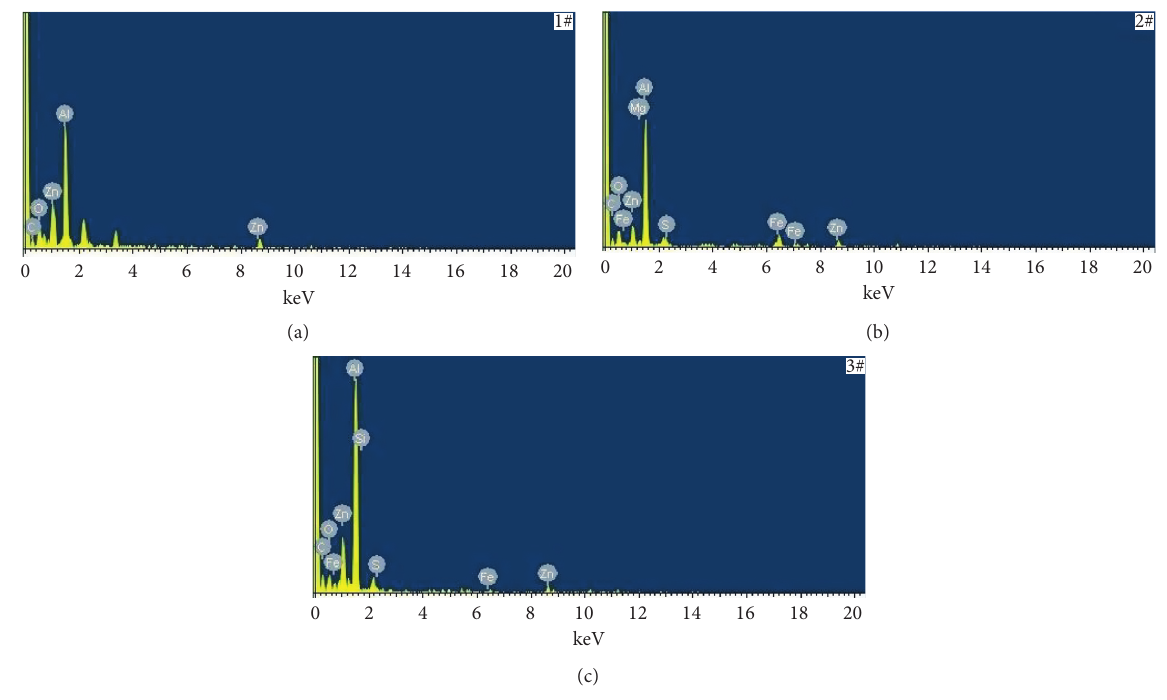
Figure 7: EDS analysis of the points circled in Figure 6.